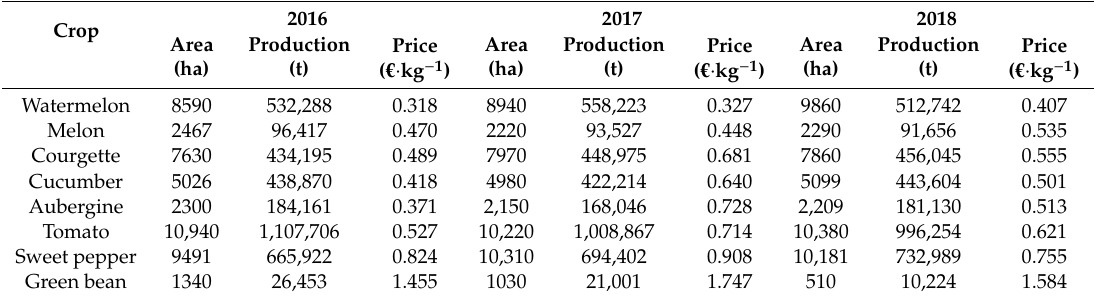
Table A1. Area, production, and price of horticultural crops in years